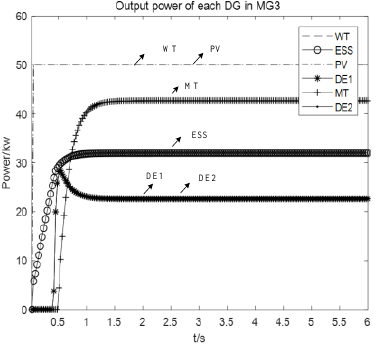
Figure 9. Equal cost increase rate of each DG .